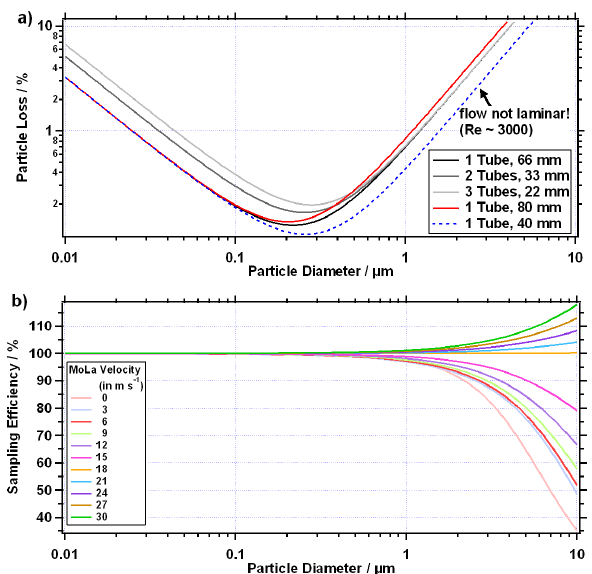
Fig. 2. (a) Transport losses in the main inlet tube as a function of particle size. Based on these calculations the 66mm ID tube was se- lected for MoLa. Multiple tubes of smaller diameter result in larger losses of small particles. A single larger tube shows more losses for large particles and for the narrow tube (40mm ID) the flow is out- side the laminar regime. (b) Sampling efficiency as a function of particle size for different driving velocities and isoaxial sampling (upper front inlet).